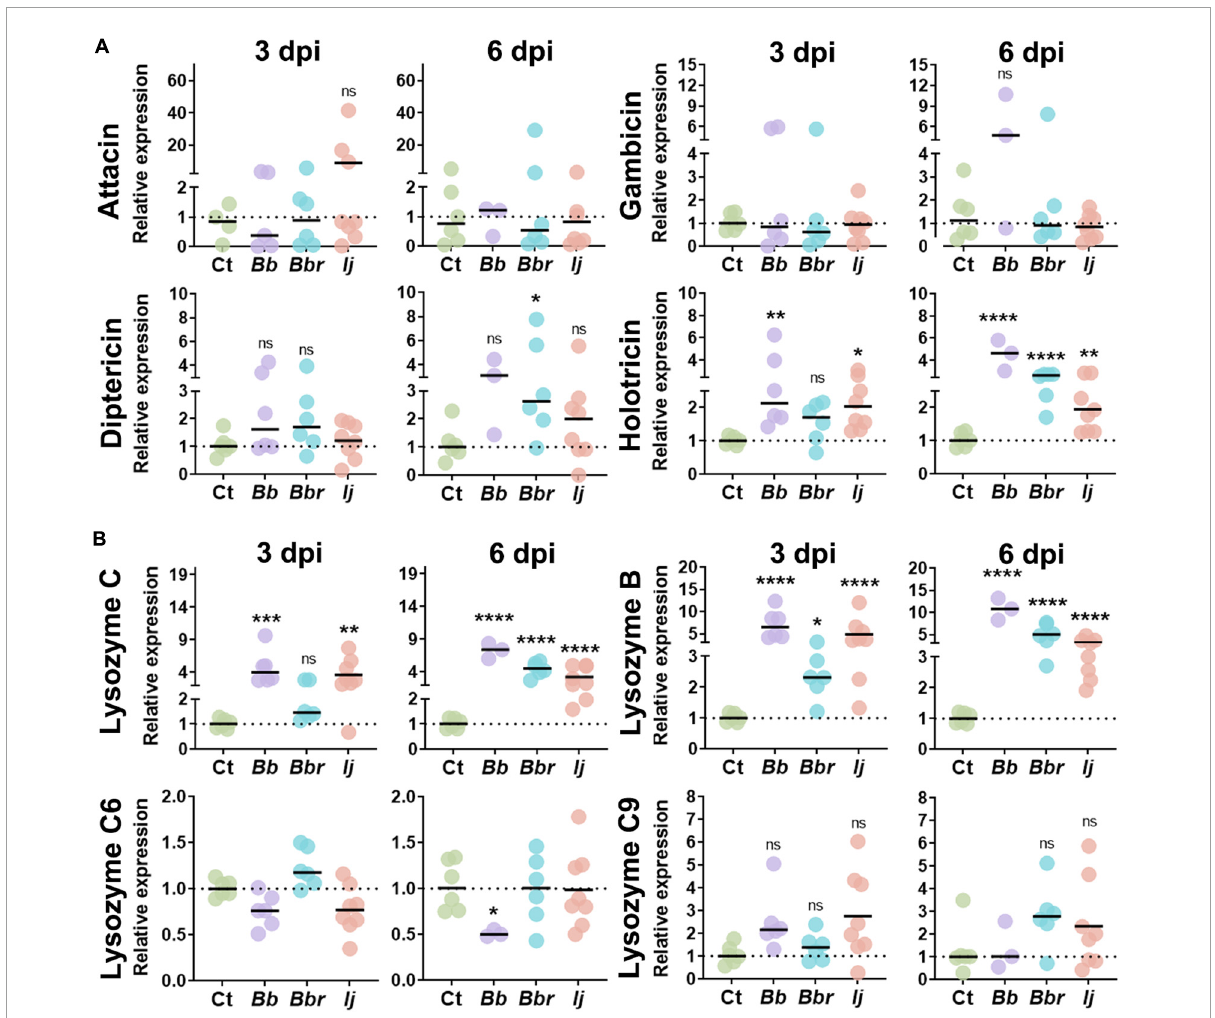
FIGURE2 AMP and lysozyme induction in Ae. aegypti mosquitoes following infection with entomopathogenic fungi. Relative gene expression profiles of attacin, gambicin, diptericin, and holotricin (A) , and lysozyme C, lysozyme B, lysozyme C6, and lysozyme C9 (B) in mosquitos infected with B. bassiana , B. brongniartii , and I. javanica at 3 and 6 dpi. The horizontal bar indicates the median level of expression from two independent experiments and each dot represents a pool of five mosquitoes. The statistical significance of relative gene expression was determined on log2-transformed values via ANOVA with Dunn’s multiple comparison test. * P < 0.05, ** P < 0.01, *** P < 0.001, and **** P <